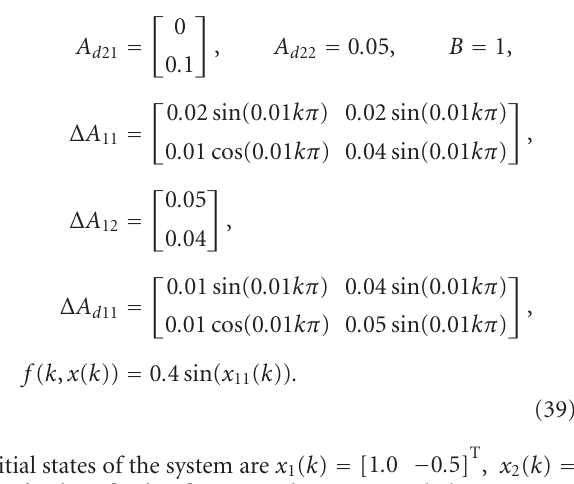
Figure 1: Time-varying delays d ( k